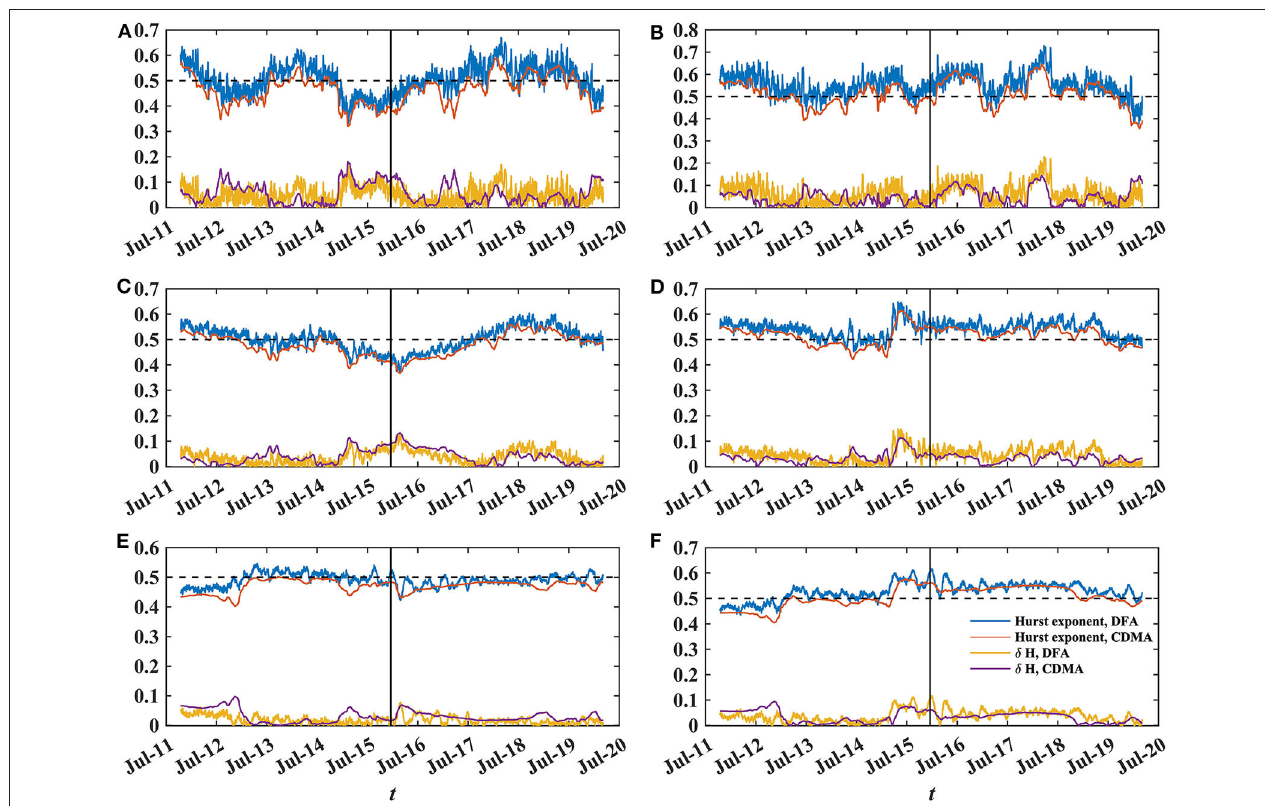
FIGURE 3 | Time-varying Hurst exponent and δ H of WTI (left panel) and Brent (right panel). The black line marks the lift of the ban. (A,B) 1 year rolling window. (C,D) 2 years rolling window. (E,F) 4 years rolling window.